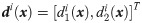
The cost vector formalism shows what determines the number of EFMs in the optimal solution.We here consider a simplified model with 2 EFMs (blue and orange), and 2 constraints. In reality, the costs of many more EFMs have to be compared, and potentially also of more constraints. The cost vector
di(x)=[d1i(x),d2i(x)]T of the ith EFM denotes the fractions of the first and second constrained enzyme pool that this EFM uses when producing one unit of objective flux. The cell-synthesis flux produced by EFM i is denoted by λi, and the corresponding enzyme costs are λidi(x). The cost of mixing EFMs 1 and 2 corresponds to the weighted sum of the cost vectors: λ1
d1(x) + λ2
d2(x). The mixture is feasible as long as none of the constraints is exceeded: λ1
d1(x) + λ2
d2(x) ≤ 1. The objective value, λ1 + λ2, is maximized by fitting a vector sum of as many vectors as possible in the constraint box. This solution is shown by the dashed vectors. The pure usage of one EFM with off-diagonal cost vector leads to underuse of one constraint, while diagonal cost vectors can exhaust both constrained pools. A mixture of EFMs will always be a combination of an above-diagonal and a below-diagonal vector. All EFMs and mixtures thereof, can be ranked by a dot on the diagonal that denotes the average cost per unit cell-synthesis flux (see Lemma 4 in S1 Appendix for a proof). Pure usage of above-diagonal cost vectors is ranked by projecting the cost vector horizontally to the diagonal, while pure usage of below-diagonal vectors is ranked by vertical projection. Mixtures are ranked by placing a dot at the intersection of the diagonal with the line between the two cost vectors. The (mixture of) EFM(s) with the lowest average cost (i.e., with the dot closest to the origin) leads to the highest growth rate (the mathematical proof is included in S1 Appendix). The enzymatic costs of an EFM depend on the intracellular metabolite concentrations, i.e., the saturation of enzymes. The shaded regions indicate alternative positions for the cost vectors at different intracellular metabolite concentrations, two of them are shown. The blue and orange cost vectors lead to the highest growth rate when using only that EFM. We see that in the left figure the orange EFM gives rise to a higher growth rate. Upon a change of environmental conditions, the cost vectors can change, and the mixture of EFMs can become better than either single EFM (right figure). A change like this would lead to a change in metabolic behaviour.